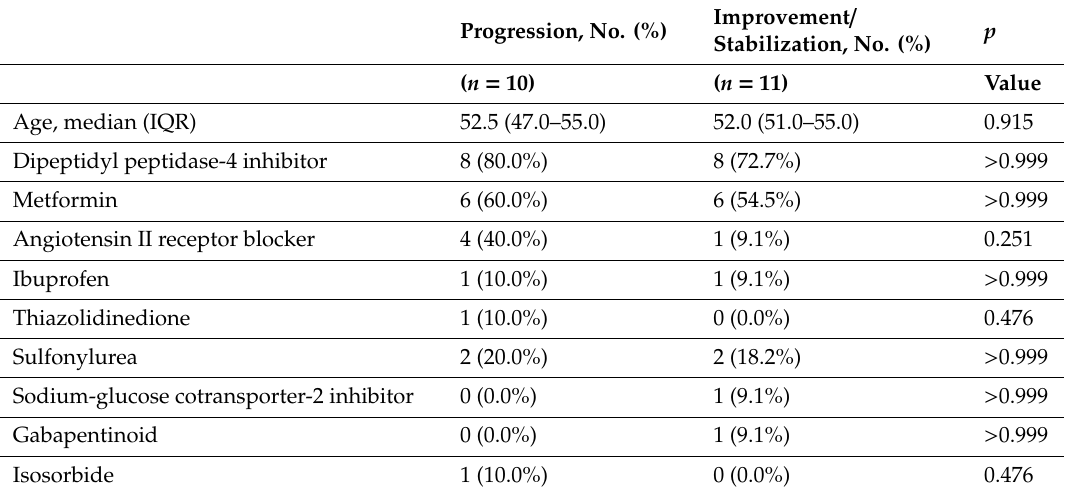
Table A3. Subgroup analysis of the e ff ect of prior use of drugs in COVID-19 patients with diabetes mellitus.